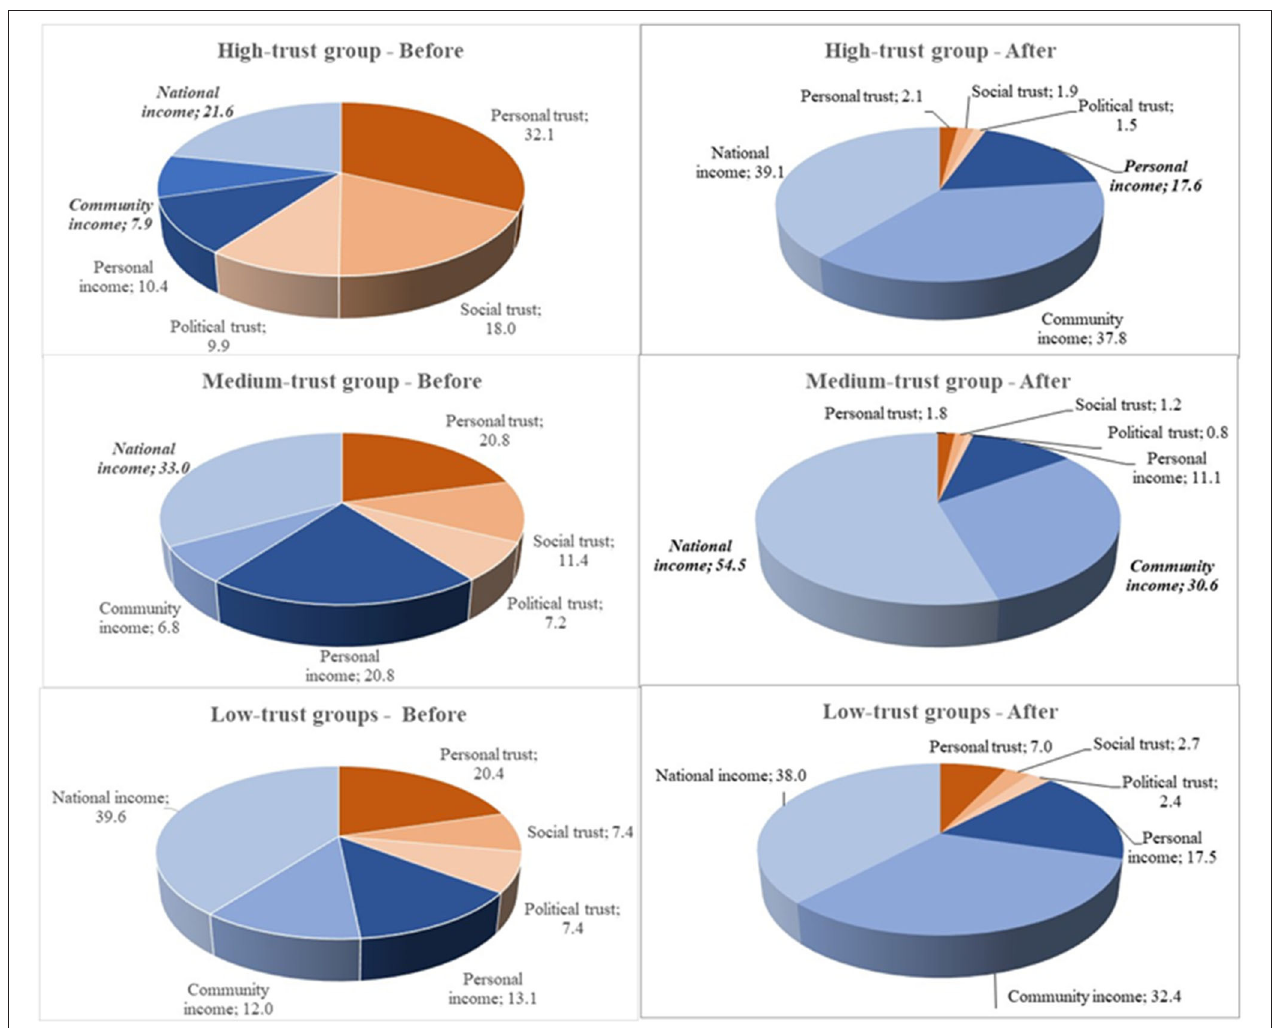
FIGURE 1 | Overview of the relative effect of personal, relative, and national income, and personal, social, and national trust on LS. Results of multilevel analysis. Levels: individual, community and country. Separated by groups of countries stratified by overall trust and as before and after financial crisis 2008/2009. N = 73,307. Significant results are in bold and those that are negative are in